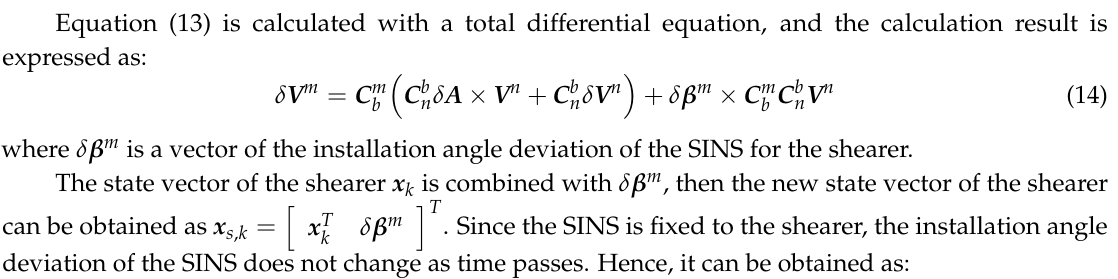
Figure 4. The relationship for different coordinates of the shearer.